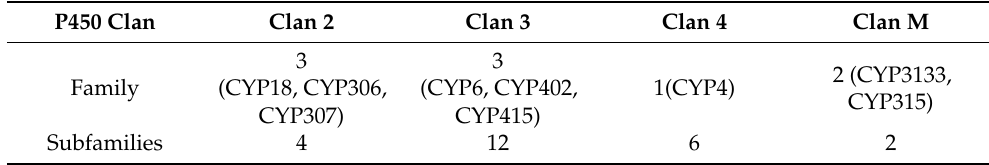
Table 2. Numbers of genes in P450 clans and families identified in Bemisia tabaci .